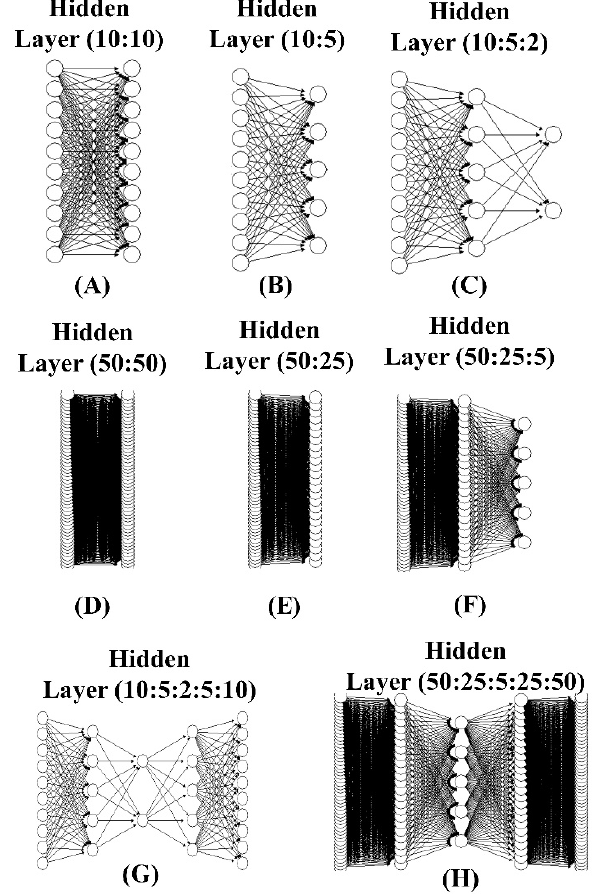
Figure 2. Number of neurons or units in the hidden layer used for hypsometric modeling of the Guazuma crinita Mart. in the Peruvian Amazon. The numbers of neurons in the hidden layer were 10:10 ( A ), 10:5 ( B ), 10:5:2 ( C ), 50:50 ( D ), 50:25 ( E ), 50:25:5 ( F ), 10: 5:2:5:10 ( G ), and 50:25:5:25:50 ( H ).